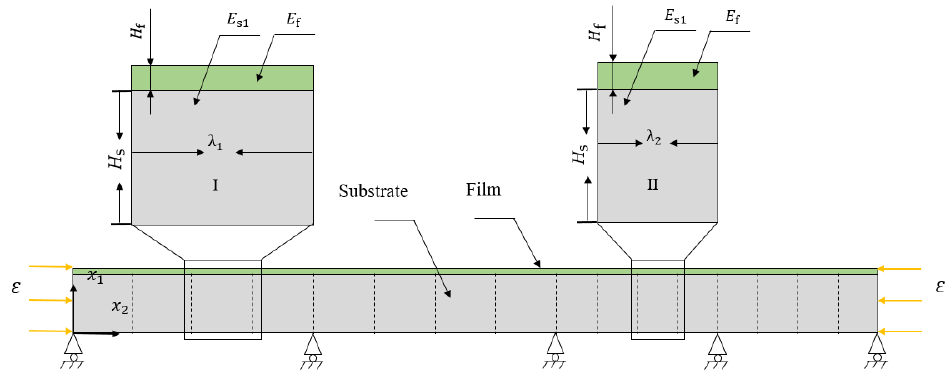
Figure 2. Finite element model hybrid film/substrate bilayer system.